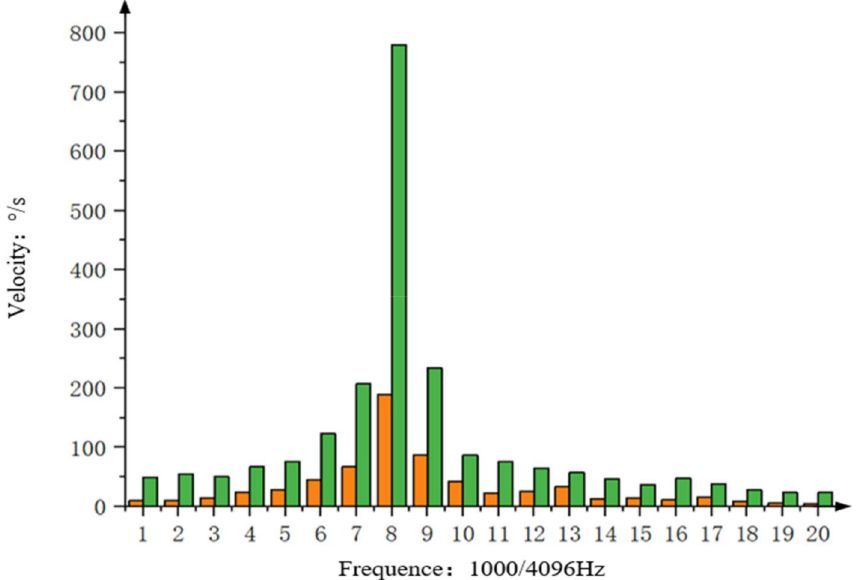
Figure 16. Fourier transform of the inner frame rate before and after using the state equalizer velocity closed loop under the disturbance of 2